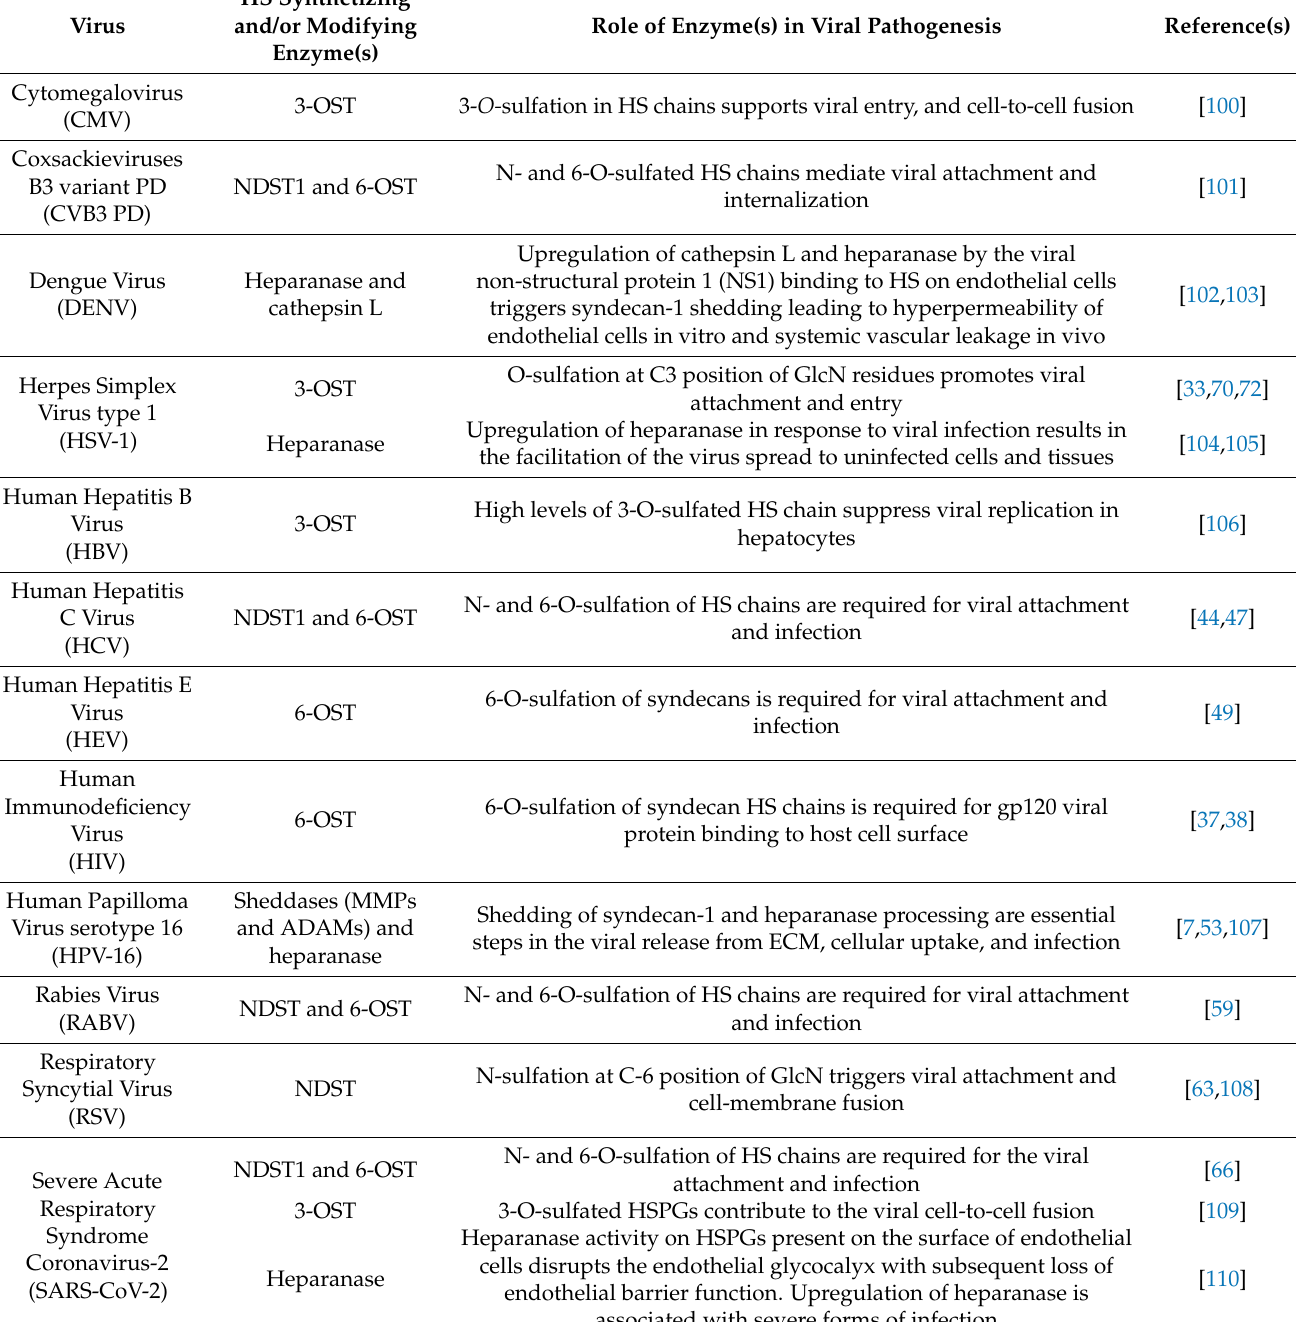
Table 2. HS synthetizing and/or modifying enzyme(s) involved in the pathogenesis of human viral infections. HS Synthetizing Virus and/or Modifying Role of Enzyme(s) in Viral Enzyme(s)